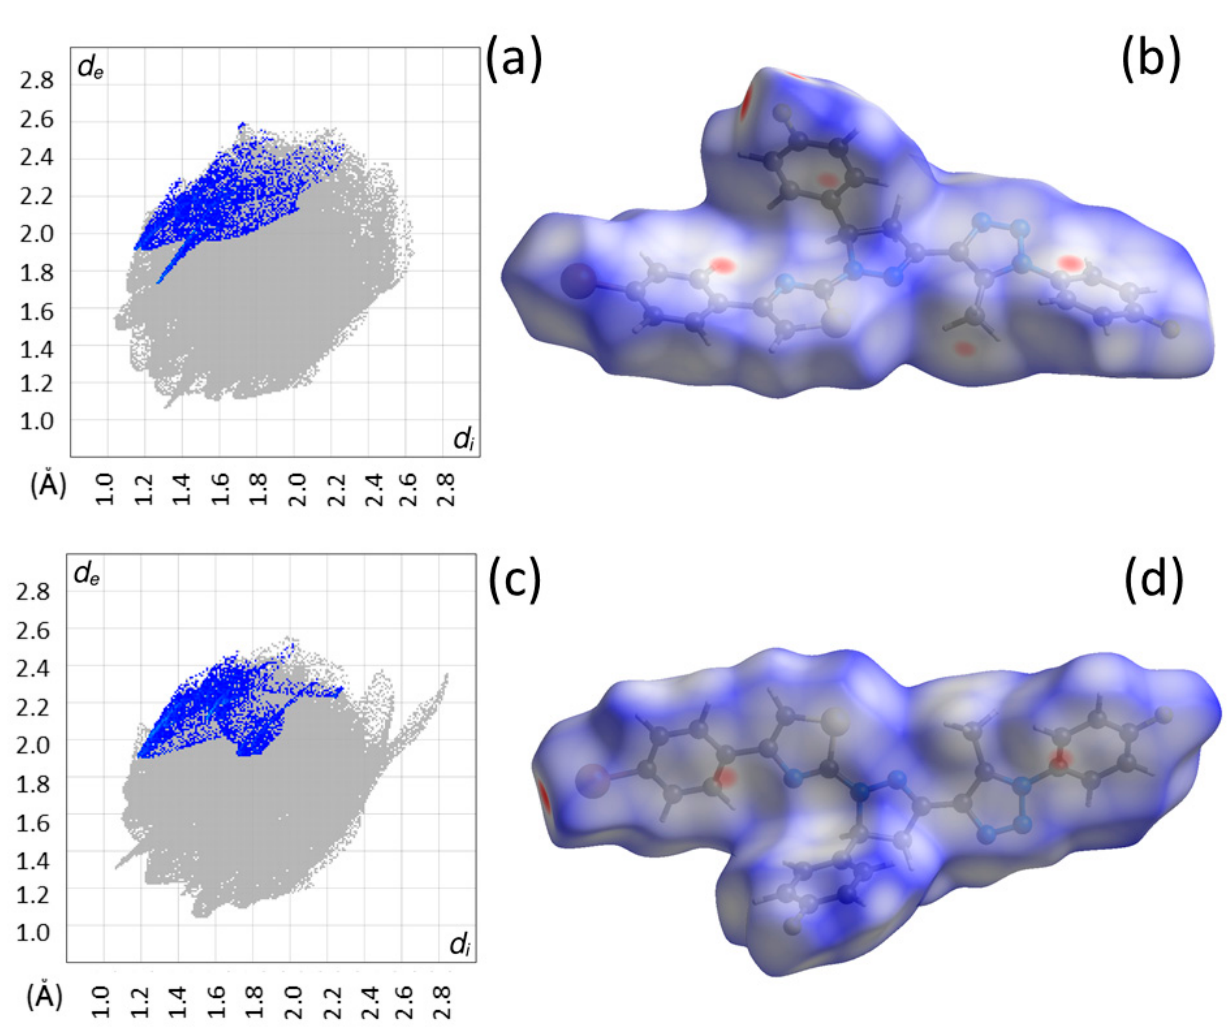
Figure 7. ( a ): Two-dimensional fingerprint plot for one independent molecule of 5 with Br interactions highlighted; ( b ): the associated Hirshfeld surface. ( c ): Two-dimensional fingerprint plot for the second independent molecule with Br interactions highlighted; ( d ): the associated Hirshfeld surface.